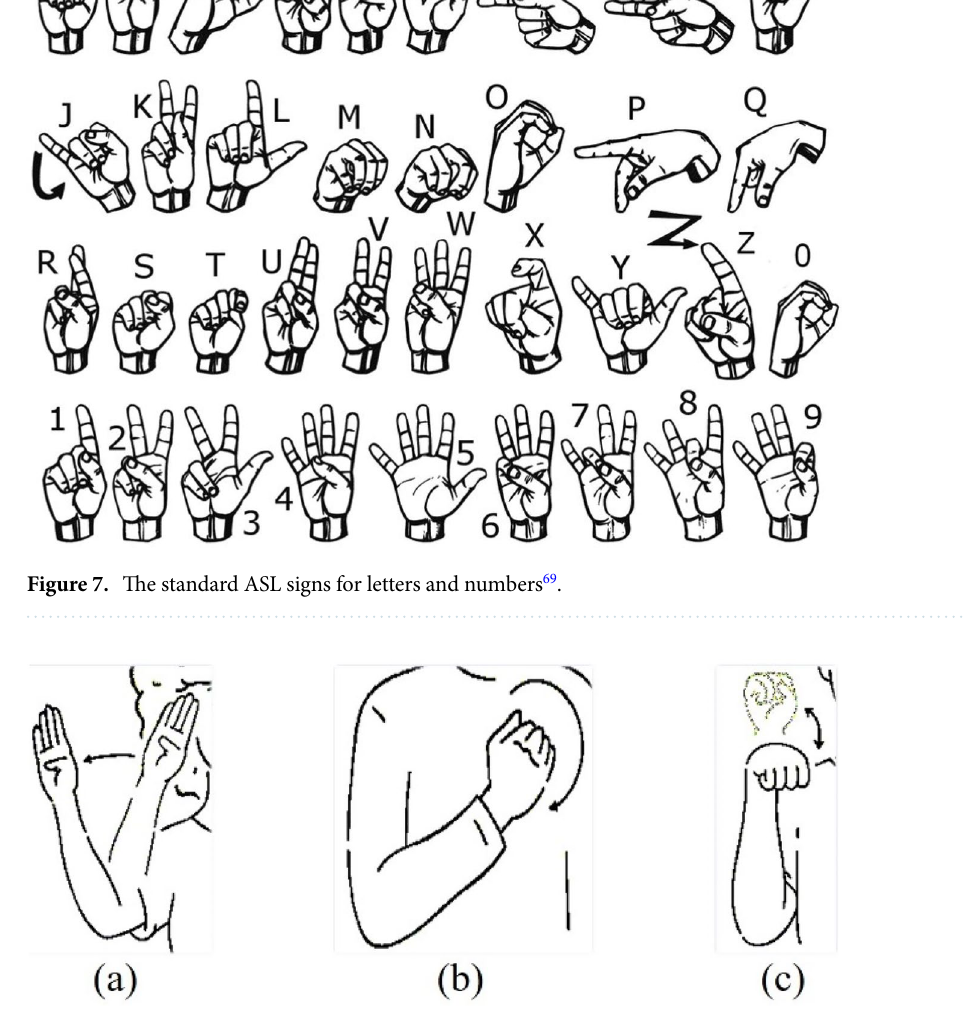
Figure 8. Differences among ( a ) ‘hello’, ( b ) ‘sorry’, and ( c ) ‘yes’